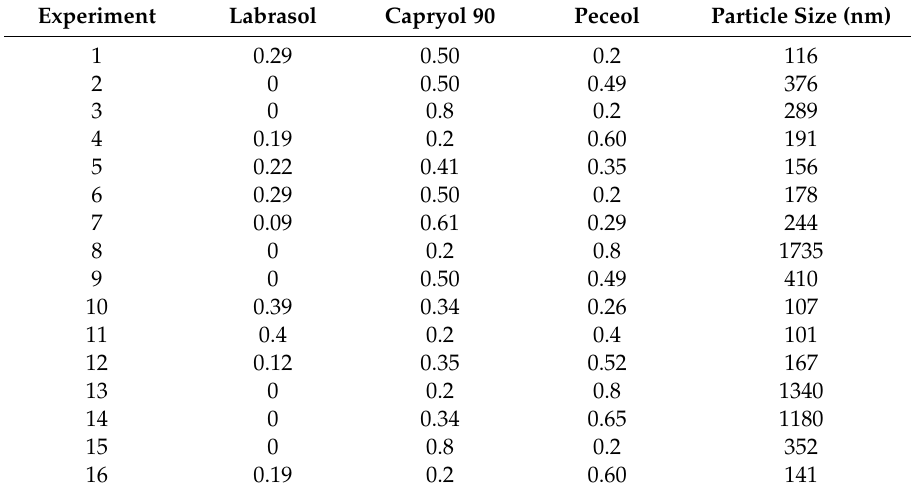
Table 2. Design of experiments (DoE) of liquid butenafine self-nanoemulsifying drug delivery systems (B-SNEDDS). Excipient quantities are expressed as a fraction, considering that the sum of all excipients was equal to 1 g. For each combination, the average particle size ( n = 3) in numbers after dilution in de-ionised water (1:1000 w / w ) was illustrated.